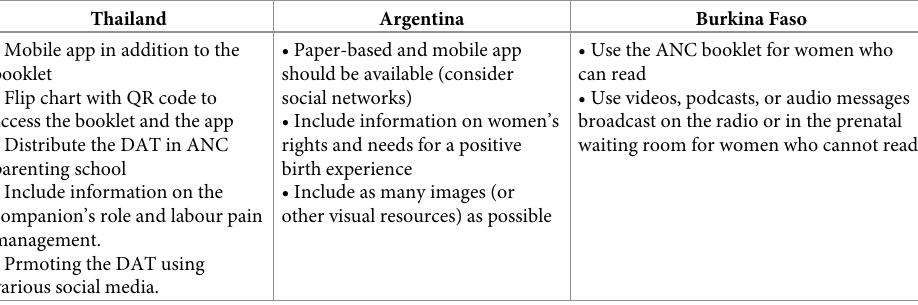
Table 5. Recommendations to facilitate DAT